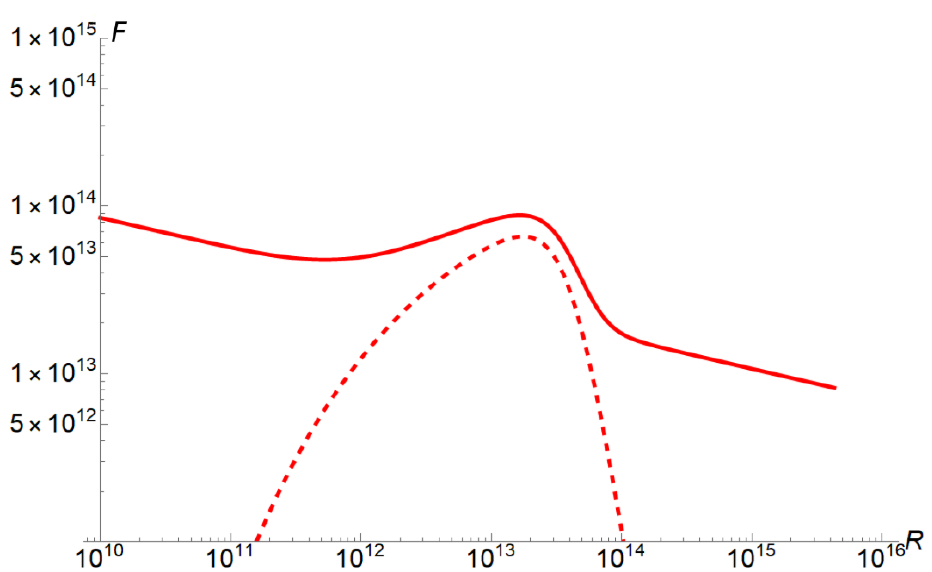
Figure 1. Model signal and background in the proximity of the flash source: the dashed line is the signal from the source; the solid line is the sum of signal with the